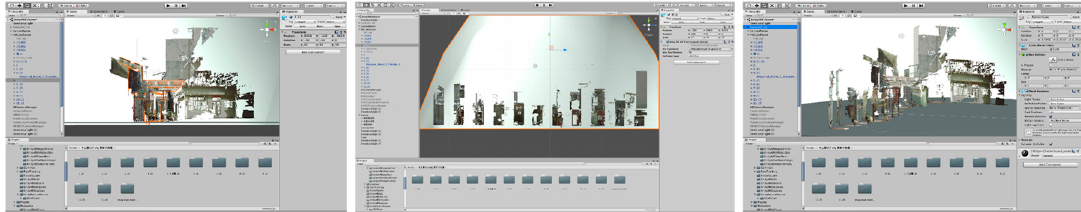
Figure 9. System developing process.